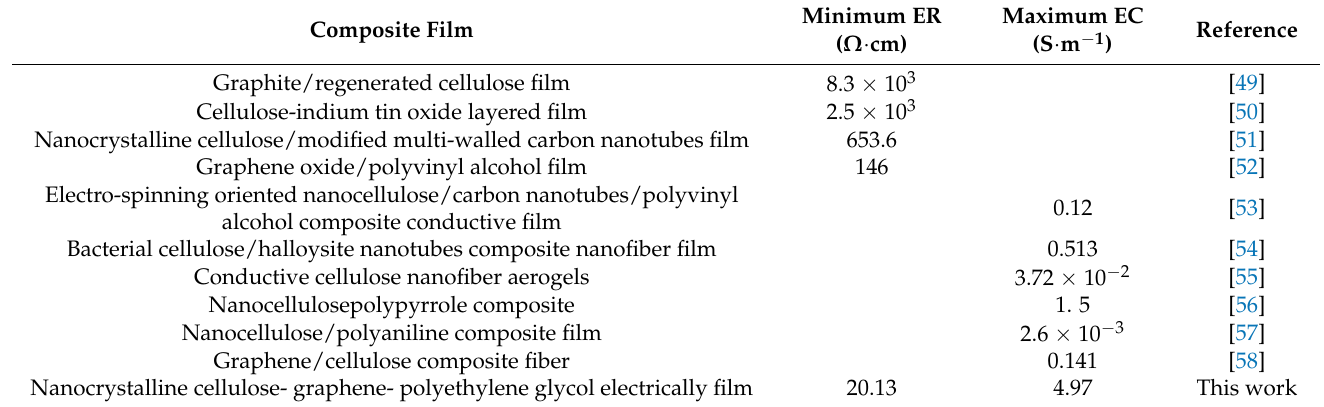
Table 2. Minimum resistivity and maximum conductivity of nanocellulose-based composite films. Composite Film